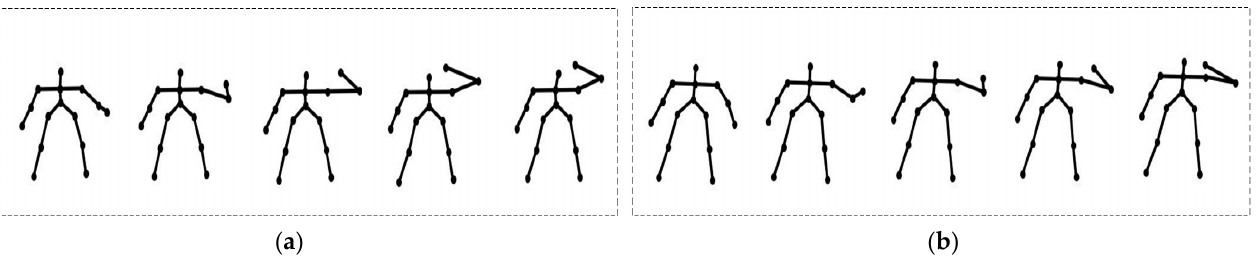
Figure 8. Five key poses of two similar actions in the Florence-3D. ( a ) Drink from bottom. ( b ) Answer phone.